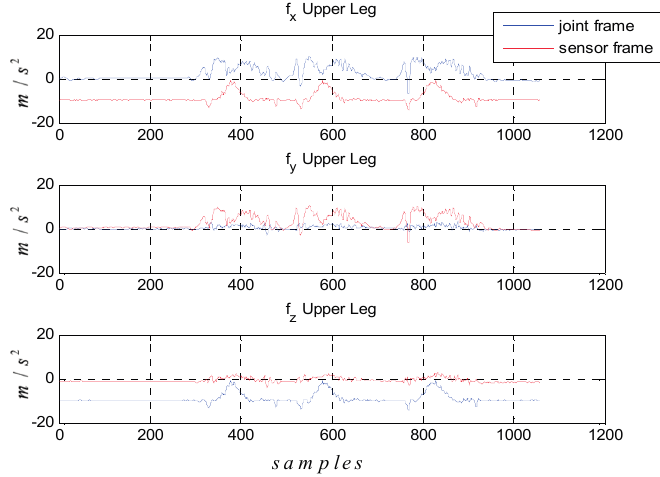
Figure 5. Accelerometer signals of upper leg during calibration motion which represented at sensor frame ( red line ) and joint frame ( blue line